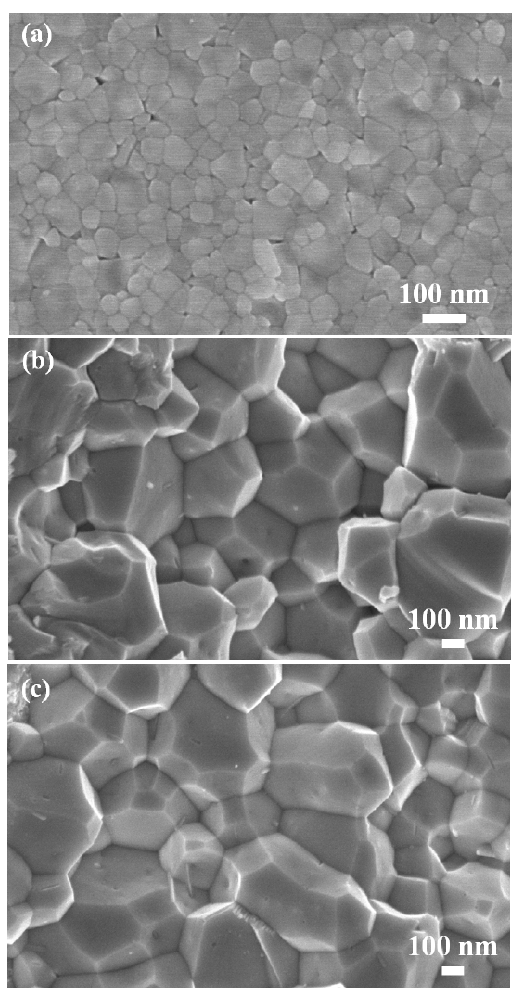
Figure 2. ( a ) Scanning electron microscopy (SEM) image for the contact surface of melt spun ribbon of Yb 0.85 Fe 3 CoSb 12 ; and SEM images for the fractured surfaces of SPSed, ( b ) Yb 0.85 Fe 3 CoSb 12 and ( c ) Yb 0.90 Fe 3 CoSb 12 bulks.